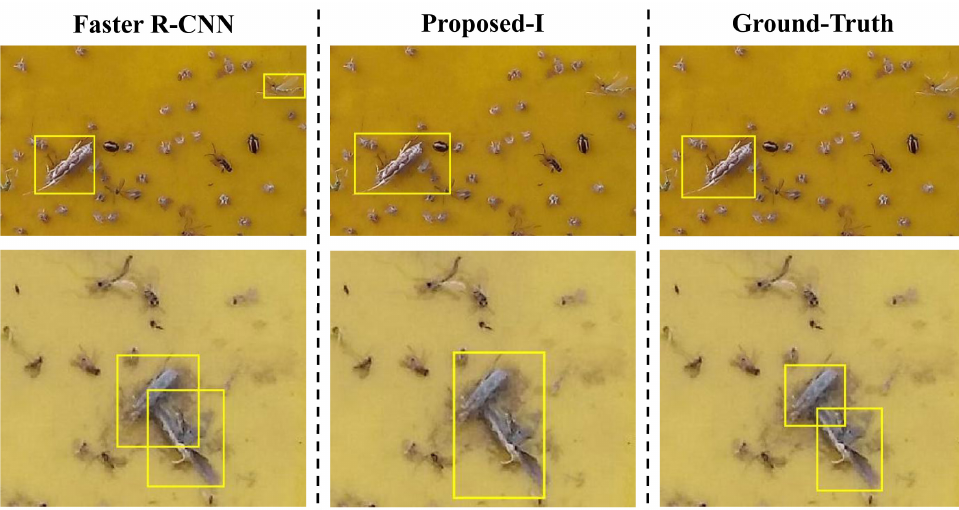
Figure 4. Illustration of the detection and classification results for the proposed scheme and Faster R-CNN over the validation set. The top row is the results of the proposed scheme, and the bottom row is those of Faster R-CNN.